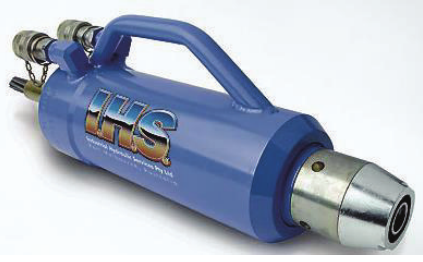
Figure 14: 25T hydraulic monostrand jack.